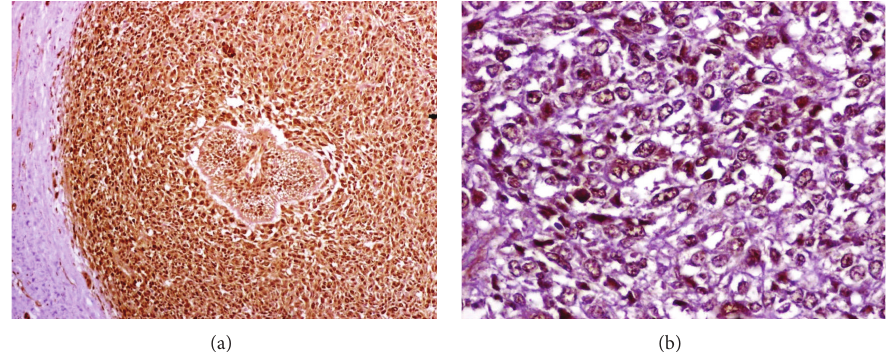
Figure 6: (a) Reactivity to PCNA in both components. Immunohistochemical stain with anti-PCNA antibody, × 50. (b) Reactivity to p53 only in the mesenchymal component. Immunohistochemical stain with anti-p53 antibody, × 400.